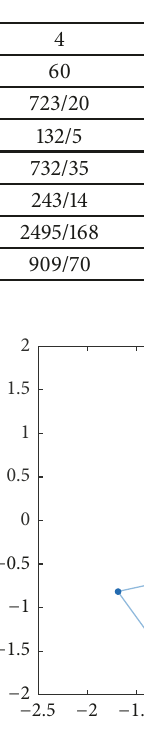
Table 3: Generalized Harary index of 𝑇𝑂𝑋 .